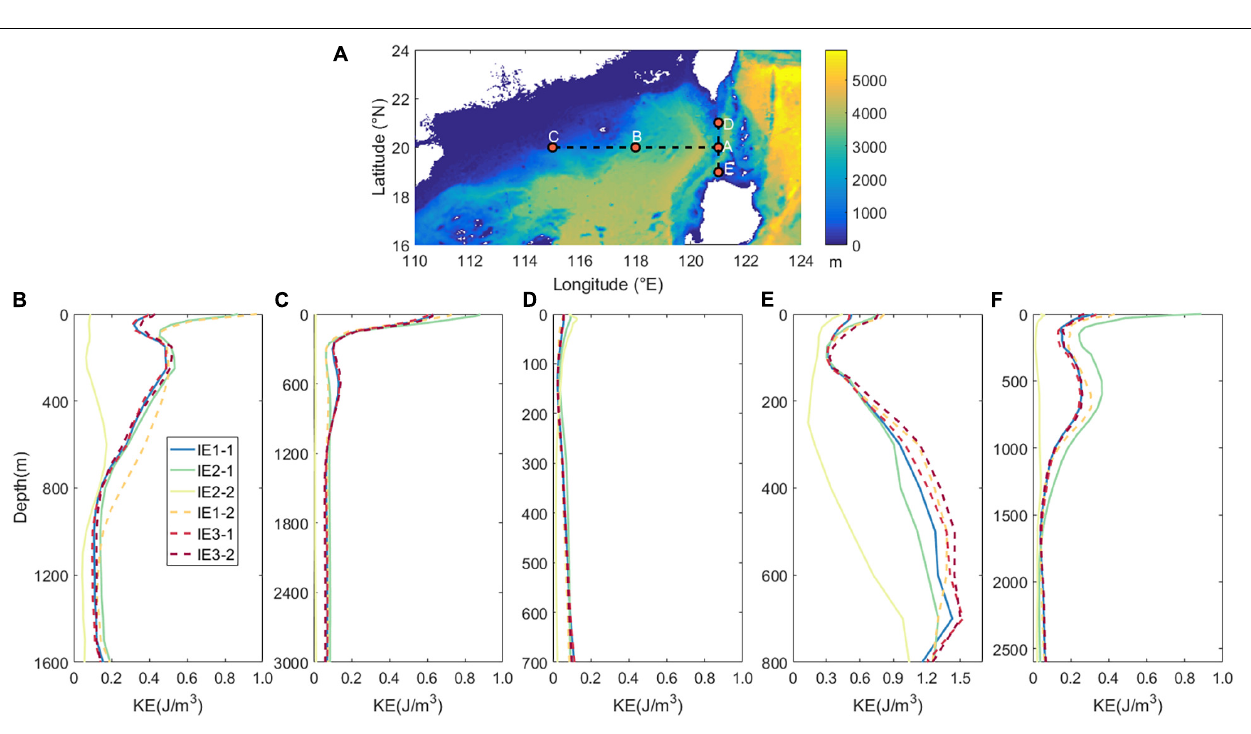
FIGURE 11 | (A) Topography in the northern South China Sea (SCS), positions of sites A to E, and temporally averaged baroclinic kinetic energy (KE) of overtides at (B–F) sites A to